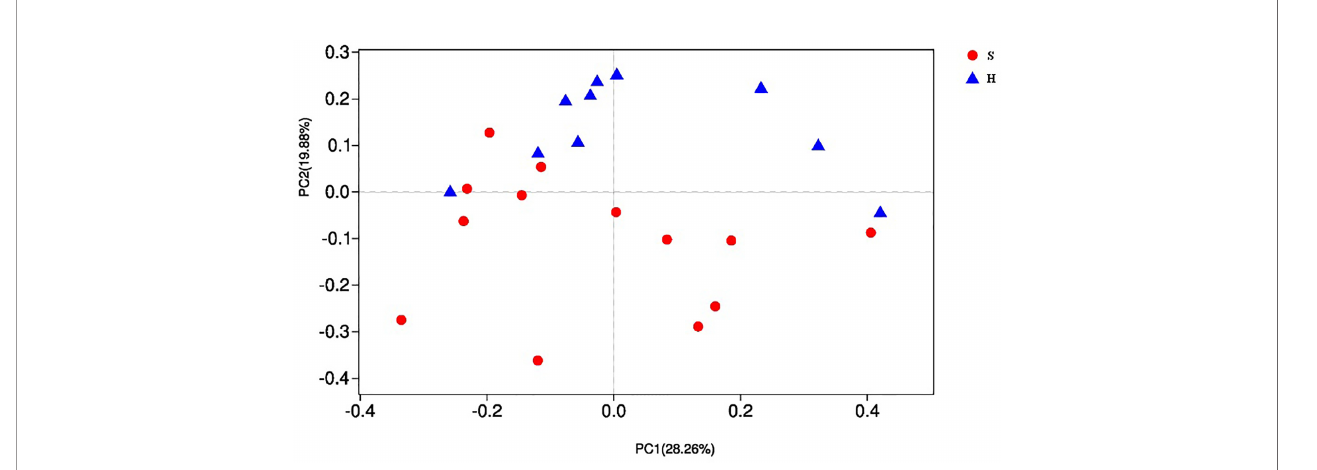
FIGURE 1 | Beta diversity by PCoA. Each sample is represented by a dot, and different colors represent different groups. As for each sample, the fi rst two main coordinates, namely PC1 and PC2 were depicted. PC1 explained 28.26% of the variation observed, and PC2 explained 19.88% of the